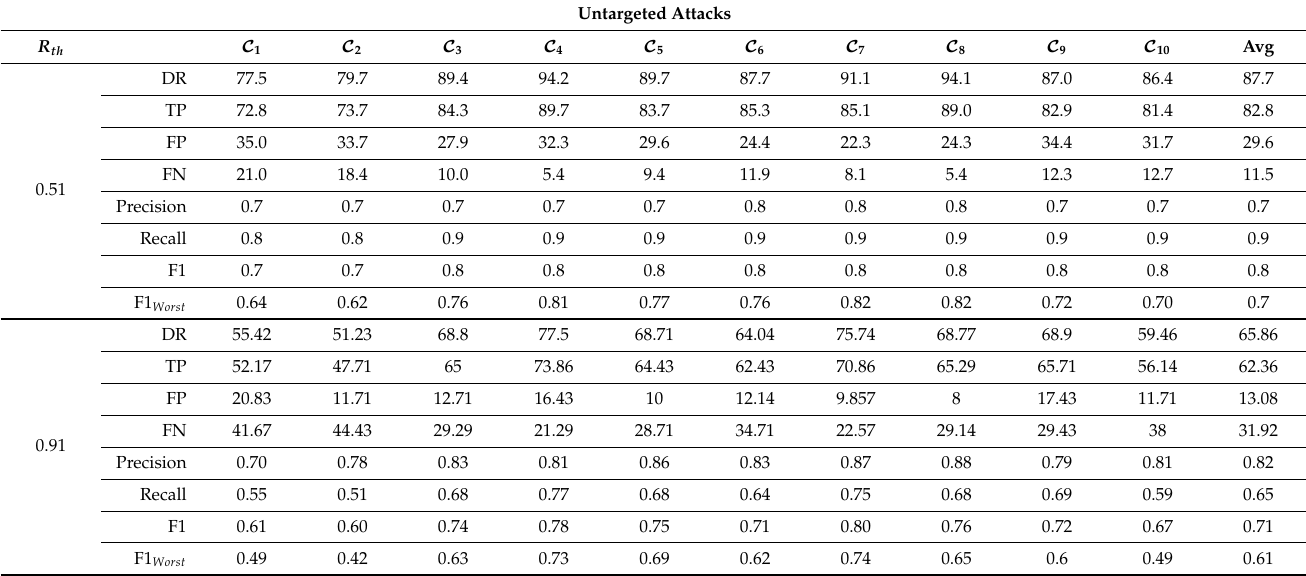
Table 14. Average for all indicators (worst case for F1) per CNN over all 7 untargeted attacks. Untargeted Attacks